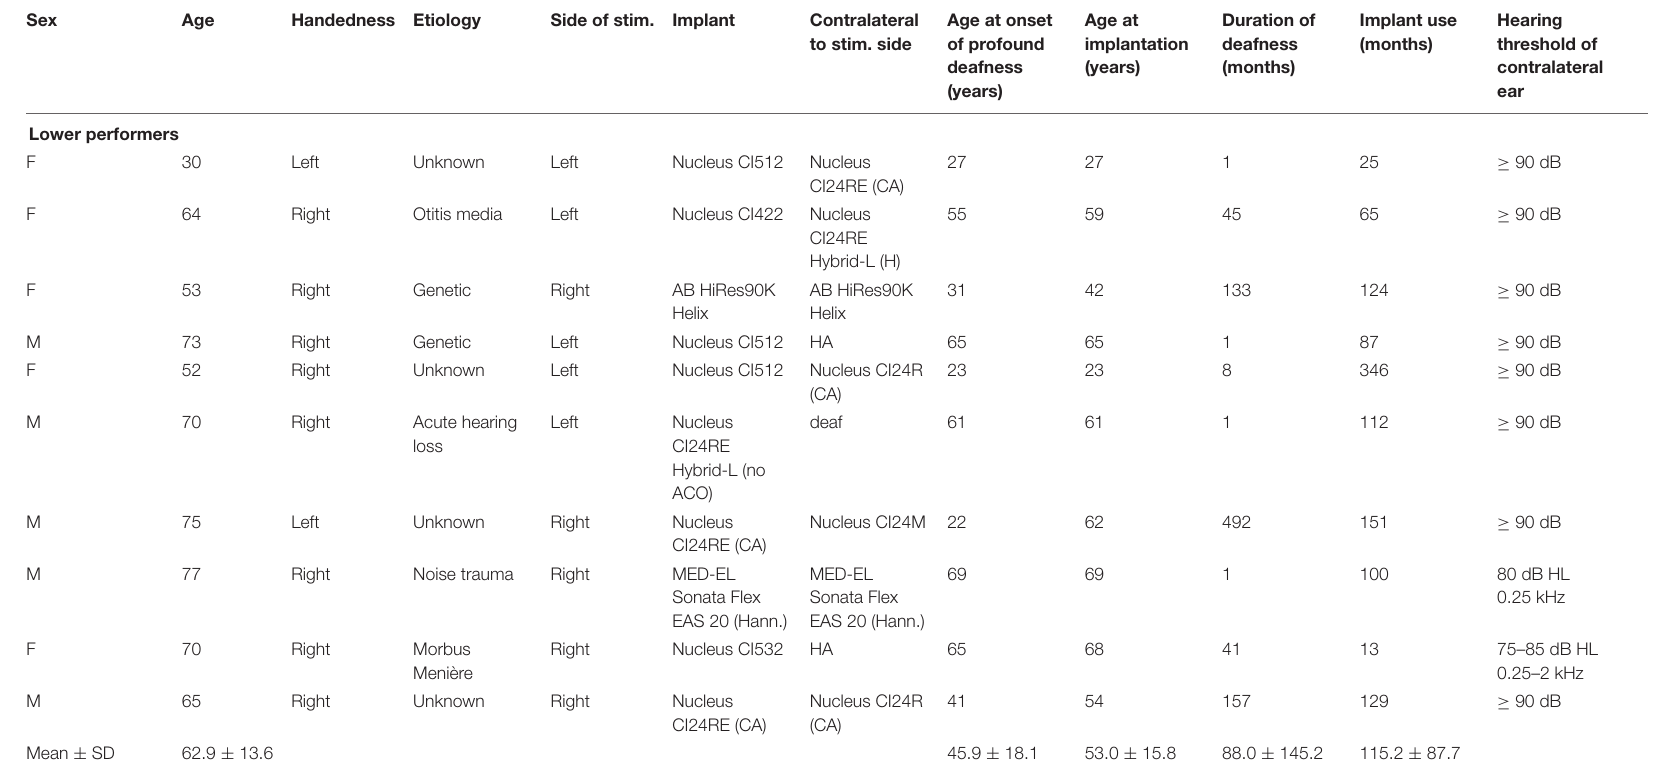
TABLE 1 | Patient